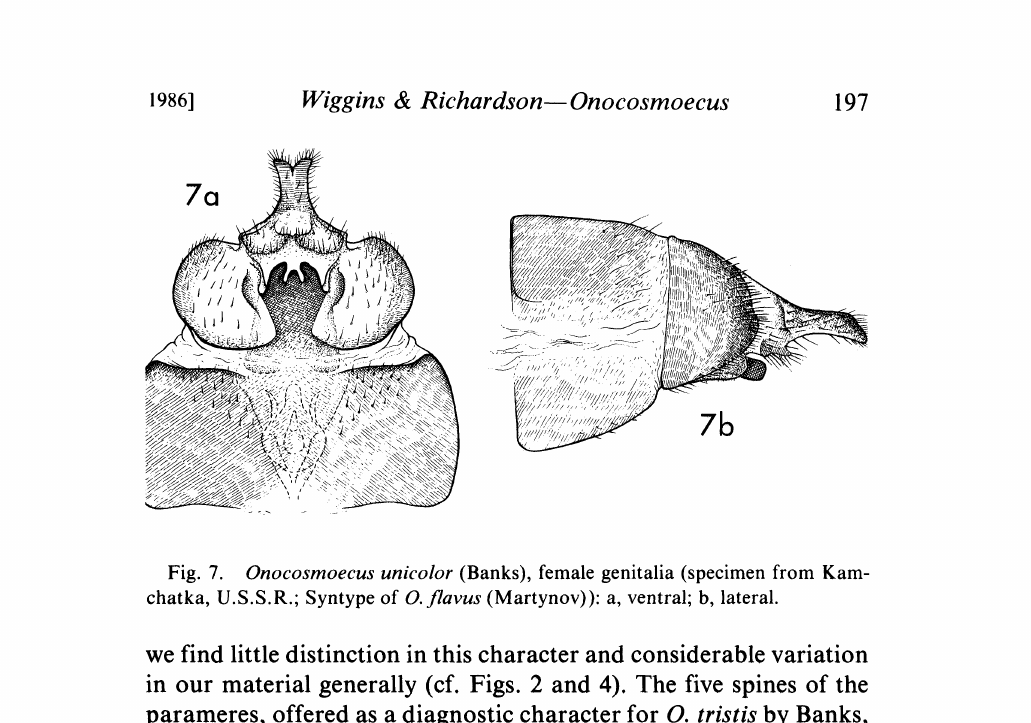
Fig. 7. Onocosmoecus uniolor (Banks), female genitalia (specimen from Kam- chatka, U.S.S.R.; Syntype of O. flavus (Martynov)): a, ventral; b,